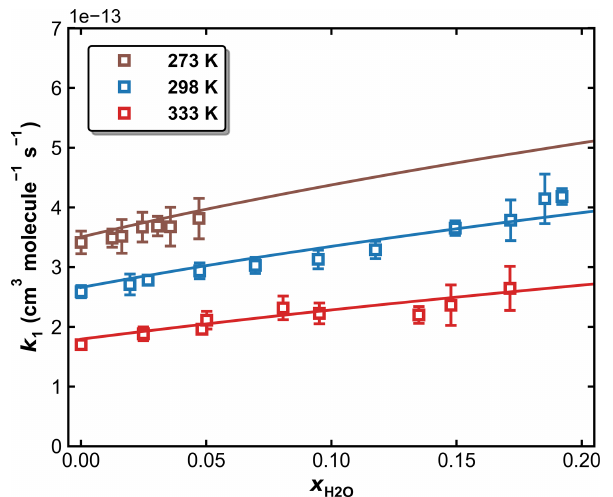
Figure 11. k 1 as a function of x H gas at a total pressure of 50Torr and different temper- atures of 273, 298, and 333K. The symbols represent measurements, and the solid lines are fits to Eqs. (5) and (6), with k 1 , ∞ = 2 . 00 × 10 − 12 cm 6 molecule − 2 s − 1 , and F C = 0 . 58. The resulting parameters for water are